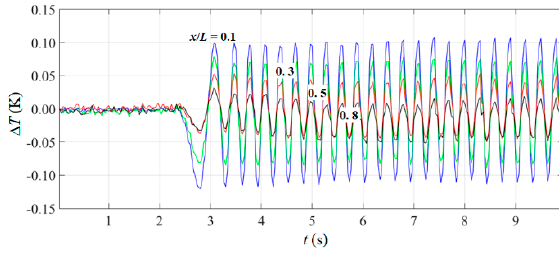
Figure 1. Δ T -time evolution during cyclic bending.